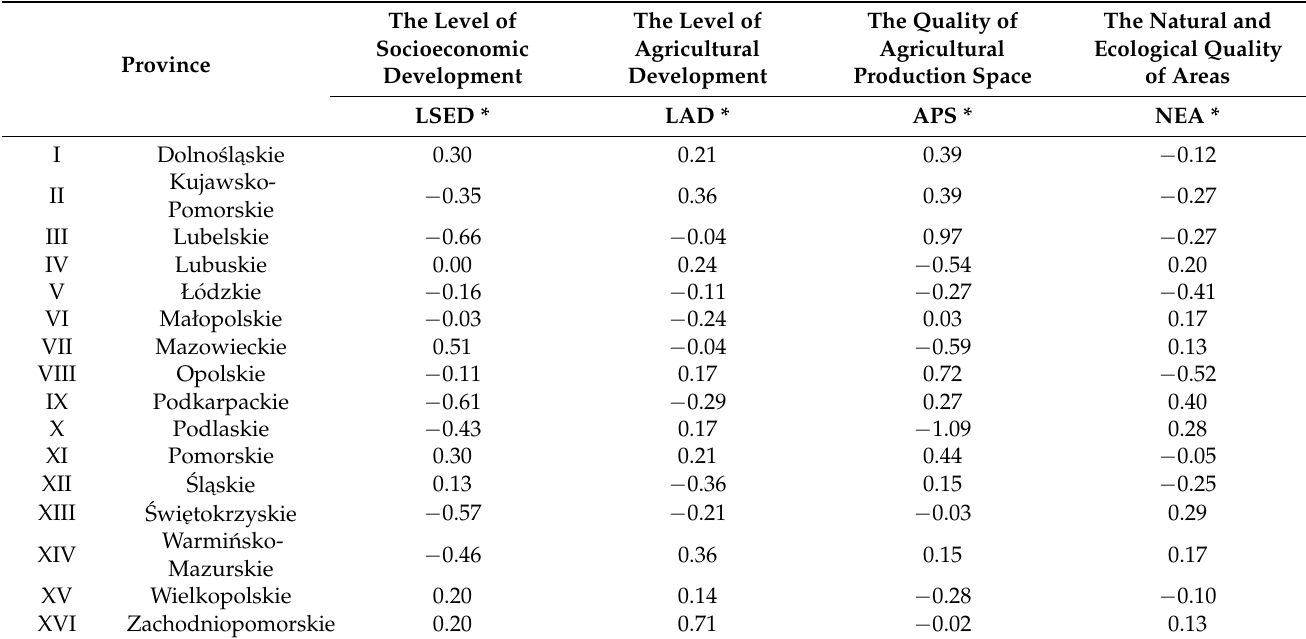
Table 3. Selected conditions for the development of sustainable agriculture in Poland (indicators in the form of a normalised value). Source: own elaboration on [66–68,72,73].